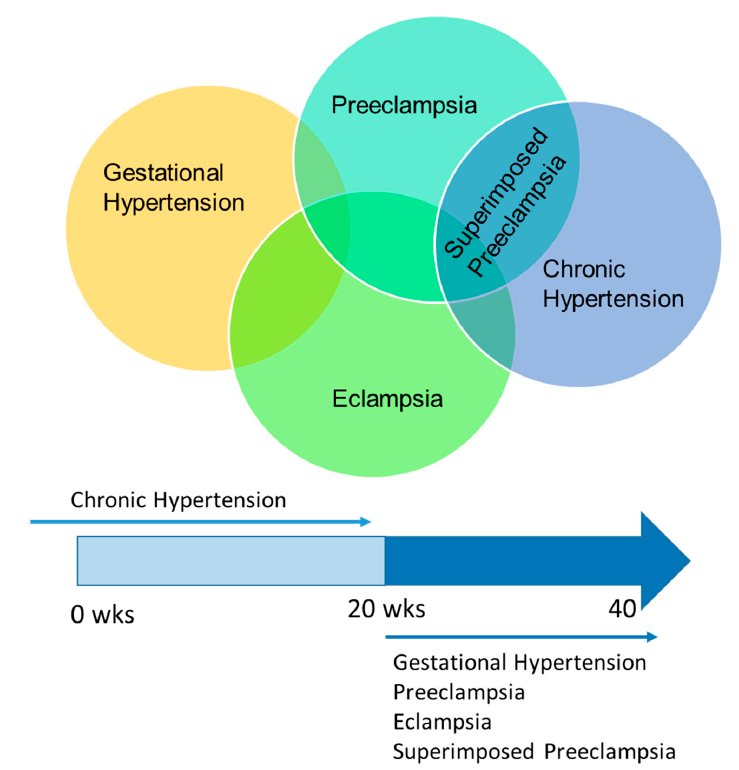
Figure 2. Different hypertensive disorders of pregnancy and their relationship to each other.